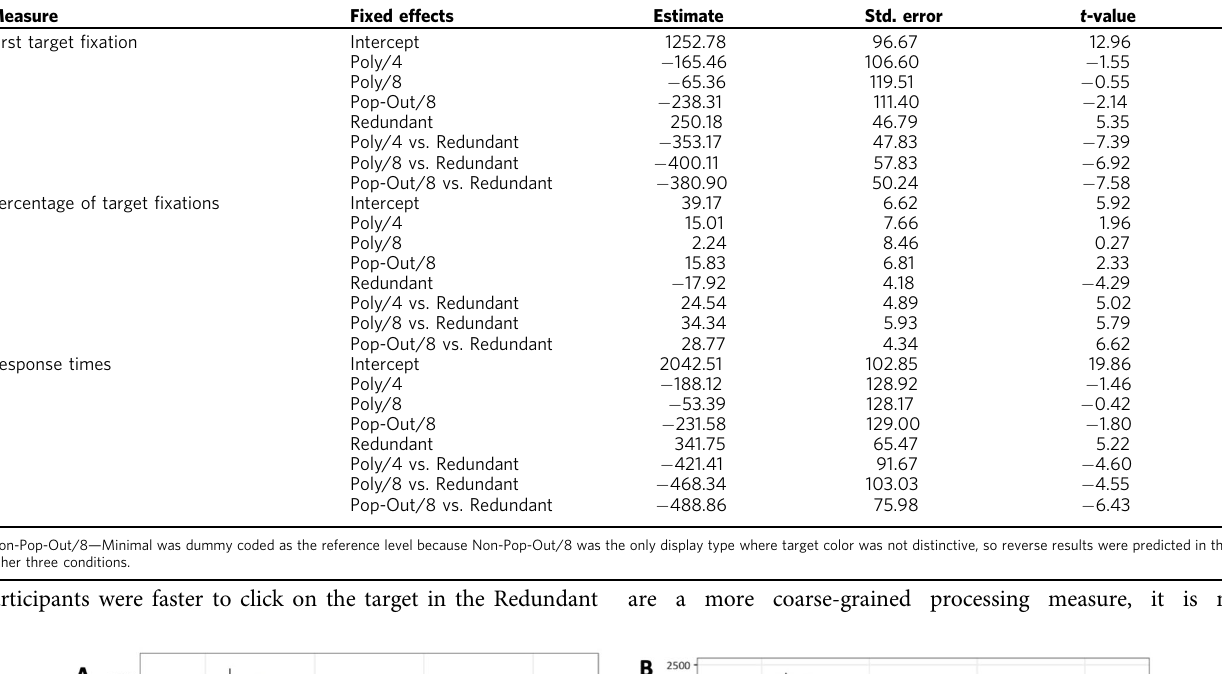
Table 1 Results of linear mixed effect models for each processing measure, positing fi xed effects of Display and Instruction plus their interaction, with random effects of Subject and Item, and the maximal random effect